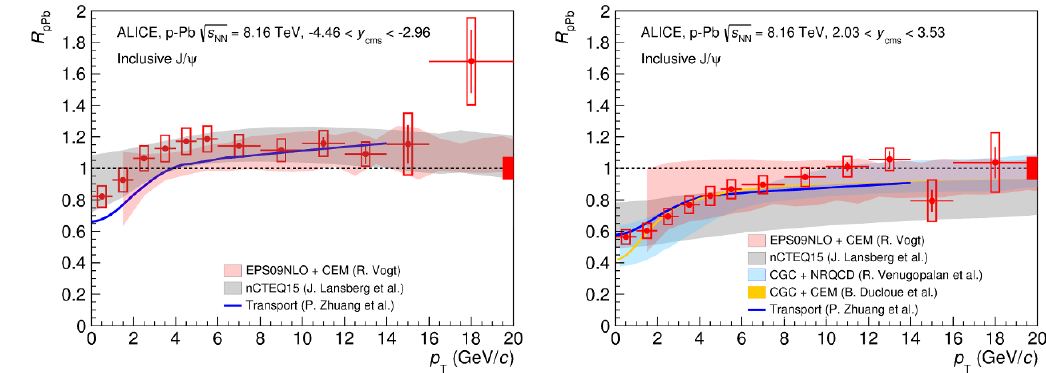
Figure 7 . Comparison of the ALICE results on the p T -dependence of the inclusive J/ nuclear modi(cid:12)cation factors in Pb{p (left) and p{Pb (right) collisions at calculations [34, 37, 62, 64{67] (see text for details). The horizontal bars on the experimental points correspond to the bin size. The vertical error bars represent the statistical uncertainties, the boxes around the points the uncorrelated systematic uncertainties and the (cid:12)lled box around unity the correlated uncertainties.